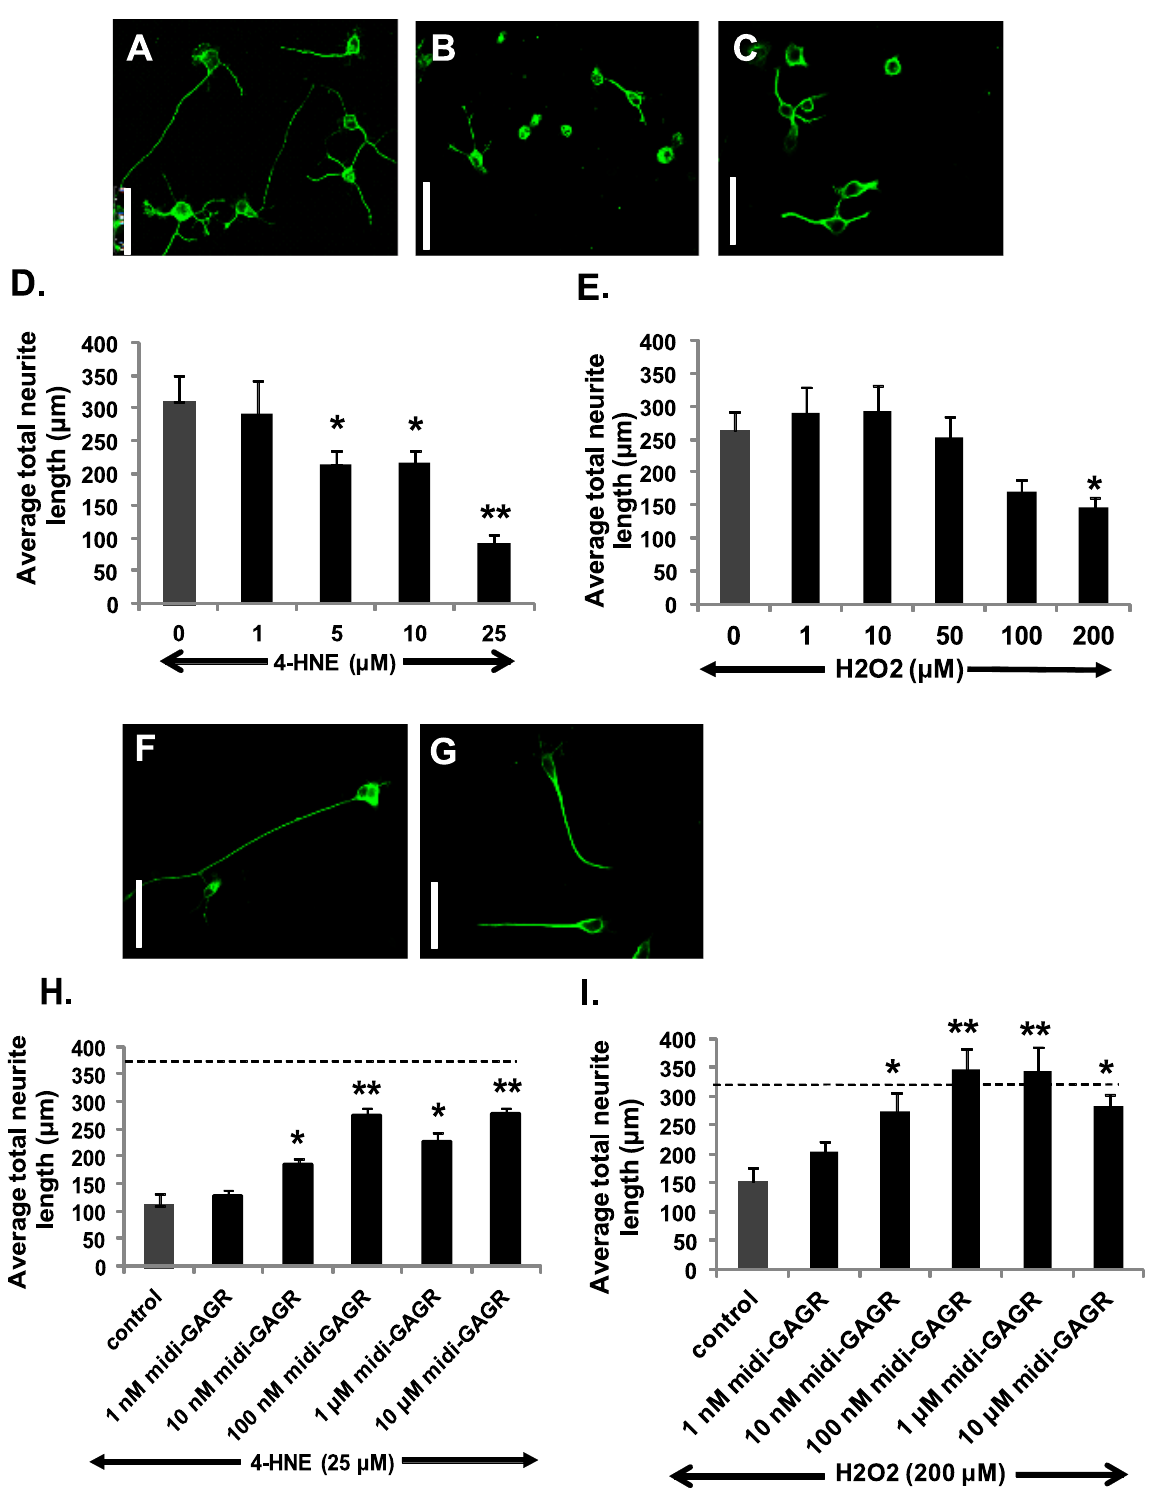
Fig 2. Midi-GAGR reverses neurite atrophy caused by 4HNE and H 2 O 2 . (A-E) Differentiated N2A cells were treated with different concentrations of 4HNE (0, 1, 5, 10 and 25 μ M) for 48 h or H 2 O 2 (0, 1, 10, 50, 100 and 200 μ M) for 24 h and immunostained with α -tubulin antibody. The representative images of N2A cells treated with H 2 O (vehicle) (A), 25 μ M 4HNE (B), or 200 μ M H 2 O 2 (C). Scale bar = 75 μ m. Bar graphs represent the average total neurite lengths of N2A cells in response to different concentrations of either 4HNE (D) or H 2 O 2 (E). * , p < 0.05 and ** , p < 0.001 compared to control. (F-I) Differentiated N2A cells were pre-treated with different concentrations (0, 0.001, 0.01, 0.1, 1, and 10 μ M) of midi-GAGR for 24 h, followed by incubation with either 25 μ M 4HNE for 48